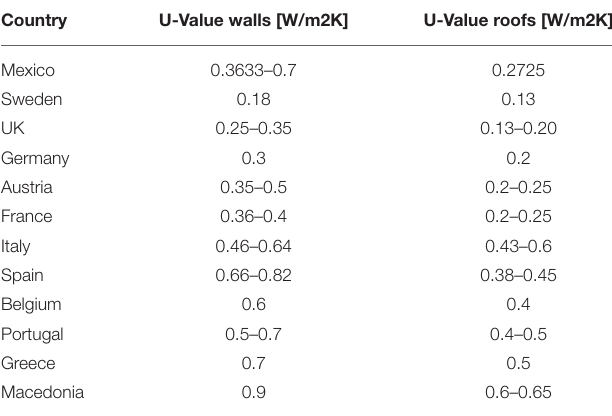
TABLE 3 | Maximum thermal transmittance (U-values) in selected countries (EURIMA, 2018; Ahlers et al., 2019). Country